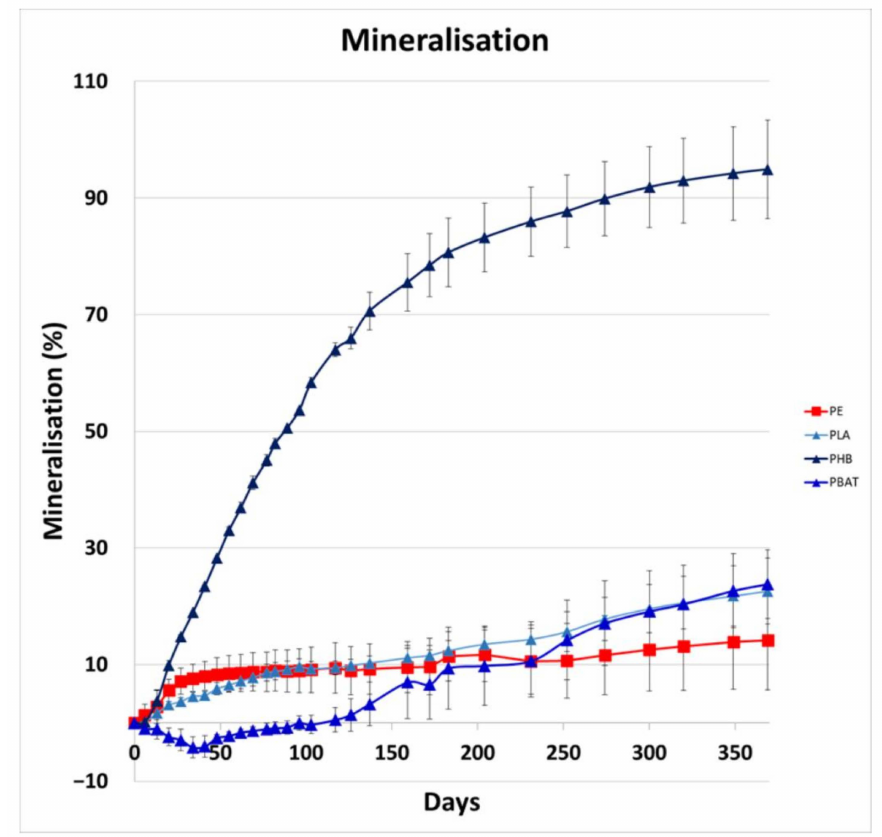
Figure 1. Mineralisation rate of tested